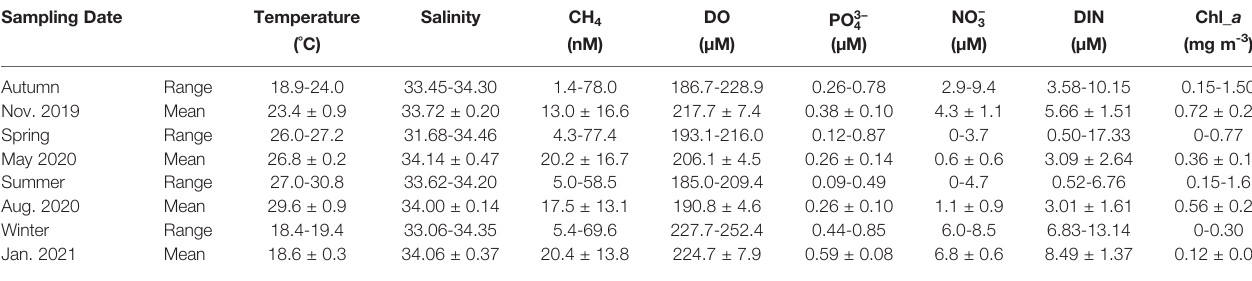
TABLE 1 | The seasonal average hydrographic data, nutrients, Chl a and CH 4